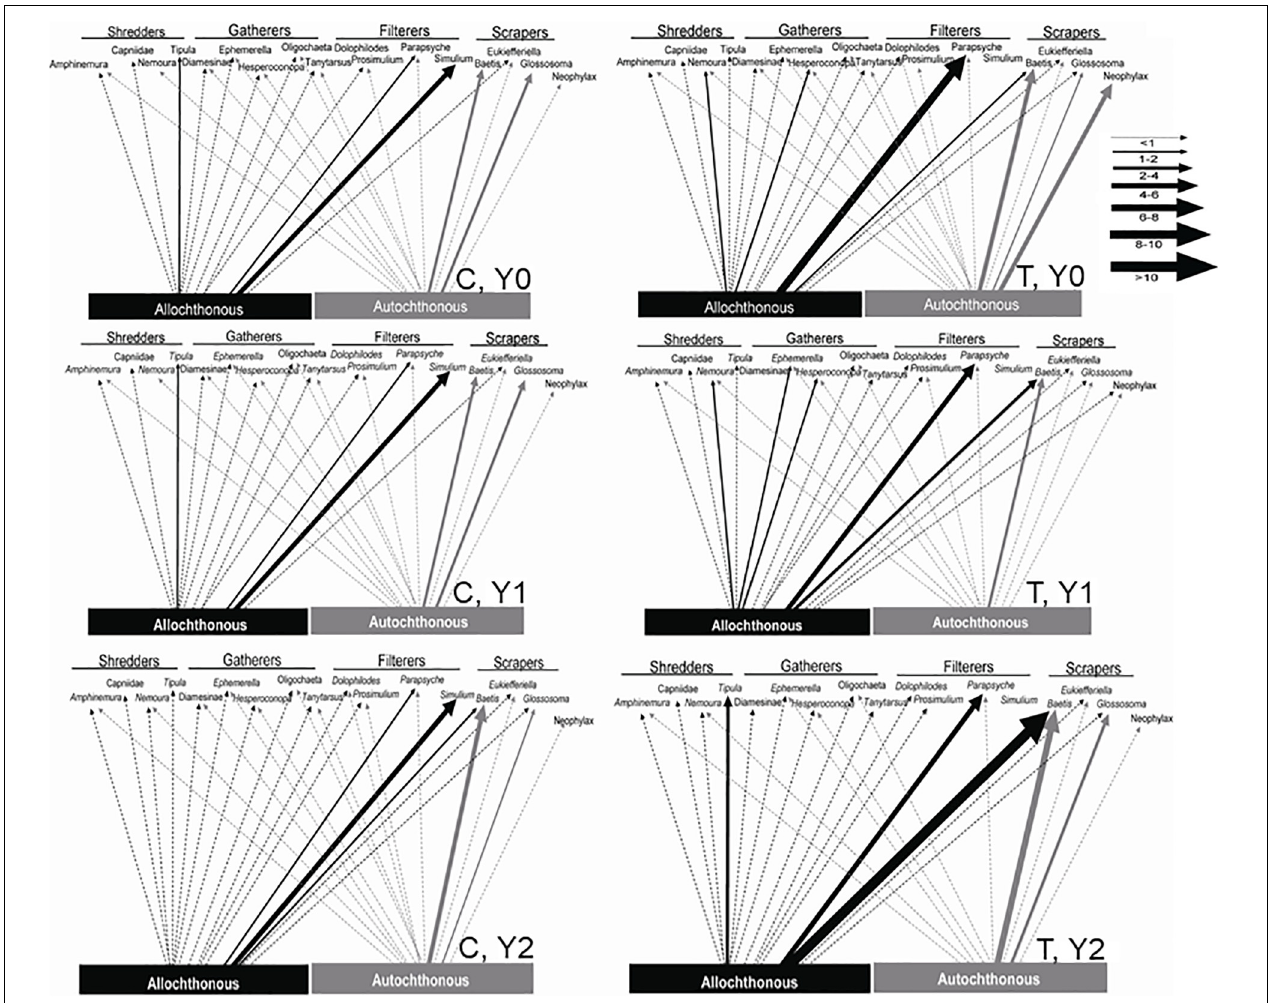
FIGURE 6 | Allochthonous (dark lines) and autochthonous (light lines) C flow to macroinvertebrate taxa in an upstream control C and downstream wood-added reach (treatment, T) 1 year before (Y0) and 1 (Y1) and 2 years (Y2) after wood addition. Arrow widths represent the proportional importance of allochthonous and autochthonous